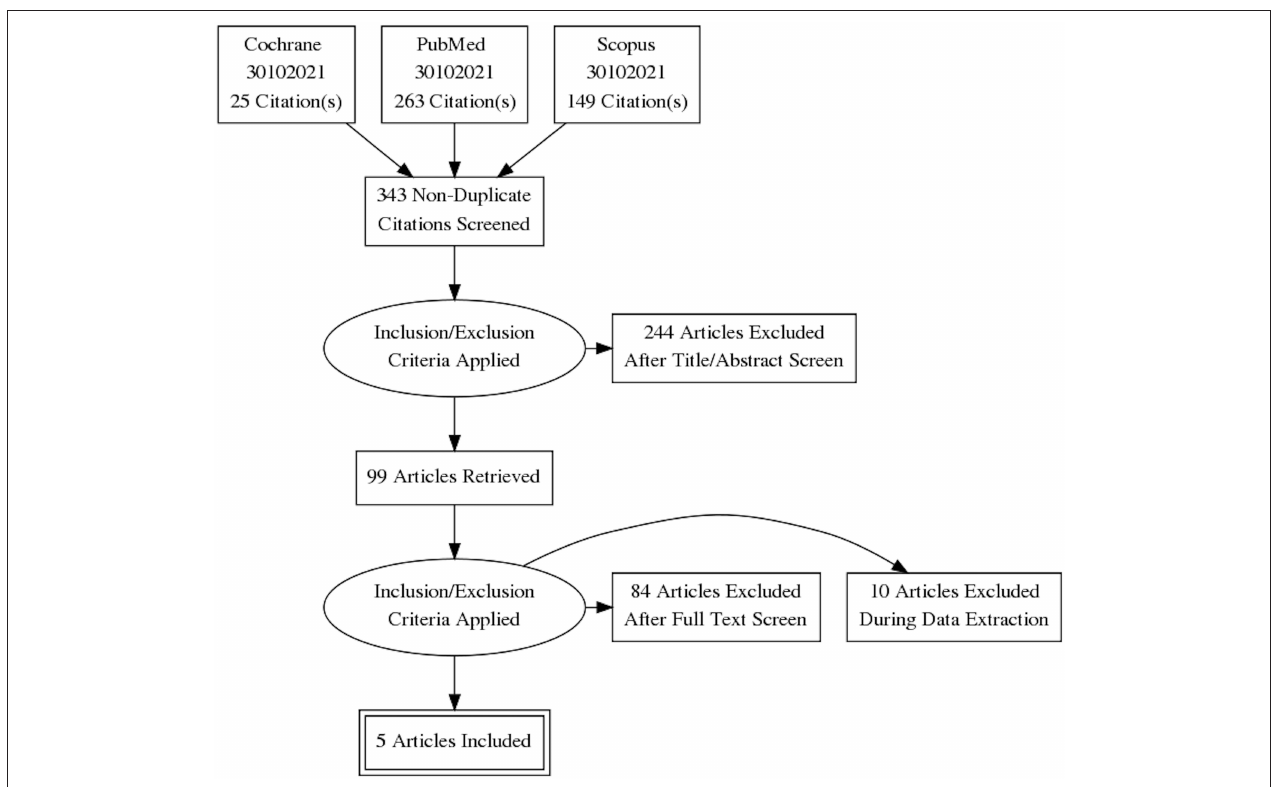
FIGURE 1 | PRISMA flow diagram for study